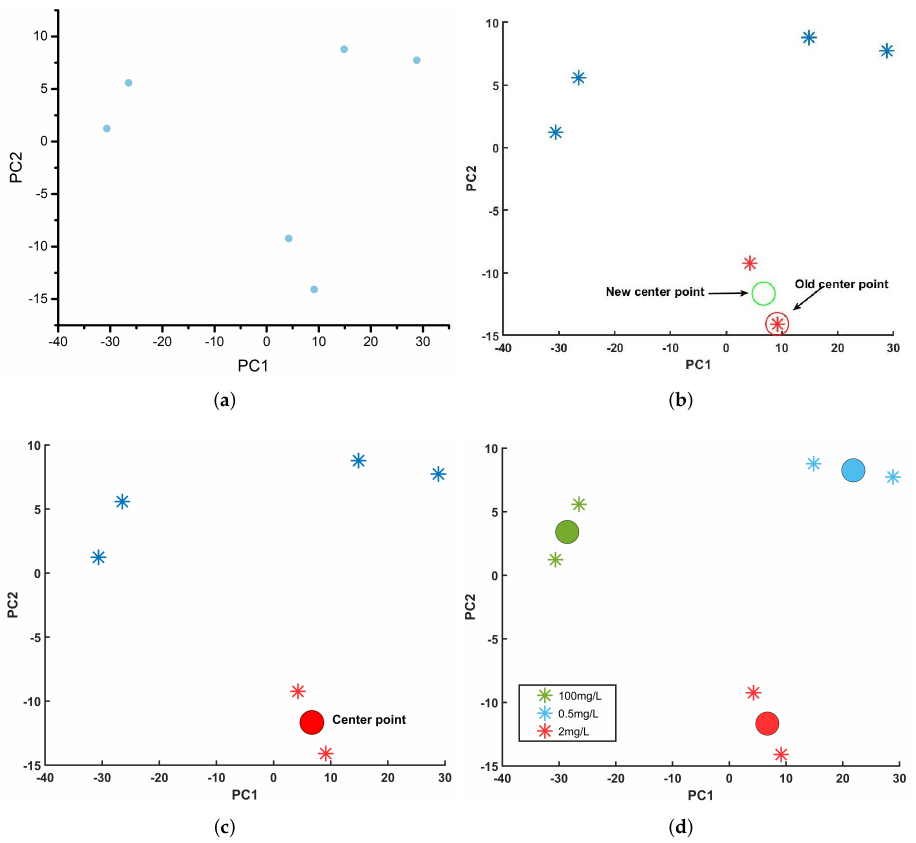
Figure 11. The result of PCA and mean shift execution process ( a ): PCA; ( b ) find a new center point; ( c ) discover the center of a cluster; ( d ) the result of mean